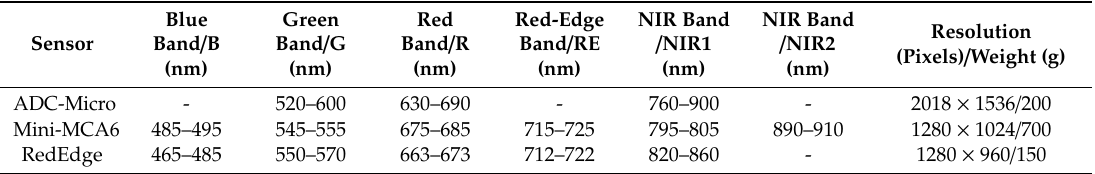
Table 1. Main parameters of studied multispectral